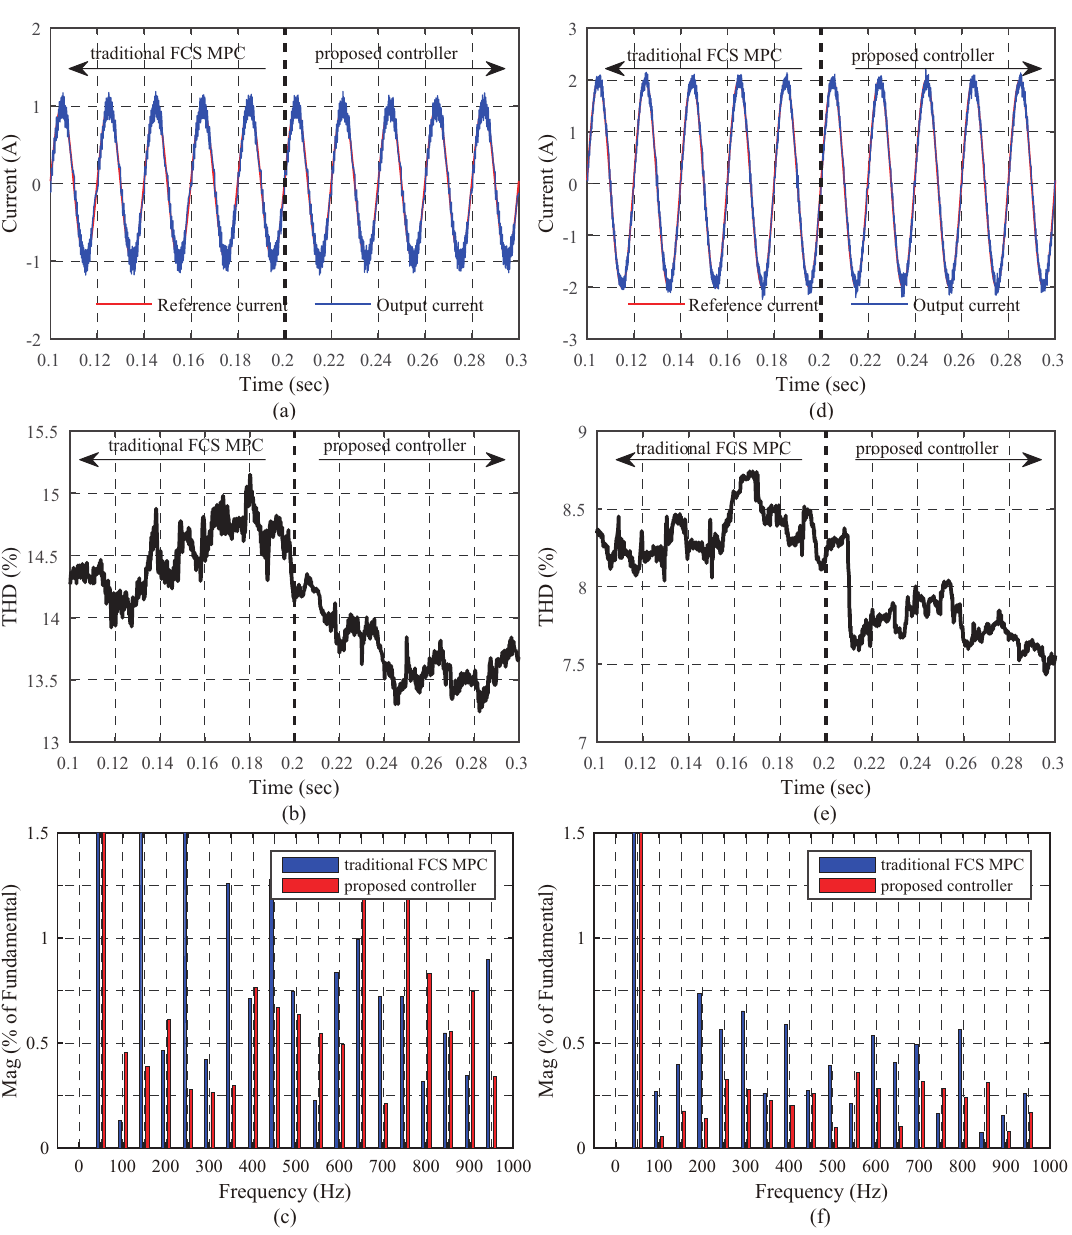
Figure 9. Experimental results of two methods: ( a ) output current with i ∗ = 1sin ω 0 t ( A ) ; ( b ) THD with i ∗ = 1sin ω 0 t ( A ) ; ( c ) harmonic analysis with i ∗ = 1sin ω 0 t ( A ) ; ( d ) output current with i ∗ = 2sin ω 0 t ( A ) ; ( e ) THD with i ∗ = 2sin ω 0 t ( A ) ; and ( f ) harmonic analysis with i ∗ = 2sin ω 0 t ( A )